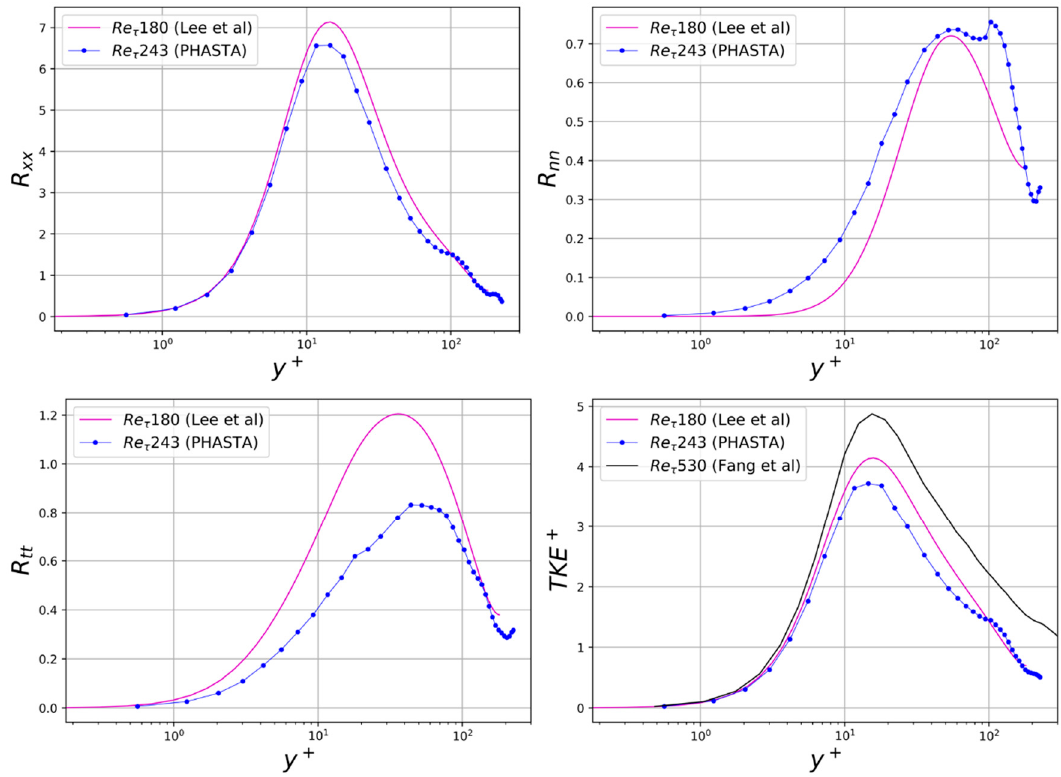
Figure 5. Comparison of mean Reynolds stress and turbulent kinetic energy (TKE) profile at the inlet cross-section with DNS data from Lee et al. [52] and Fang et al. [60] (lateral coordinates rotated to 𝑡 − 𝑛 system).